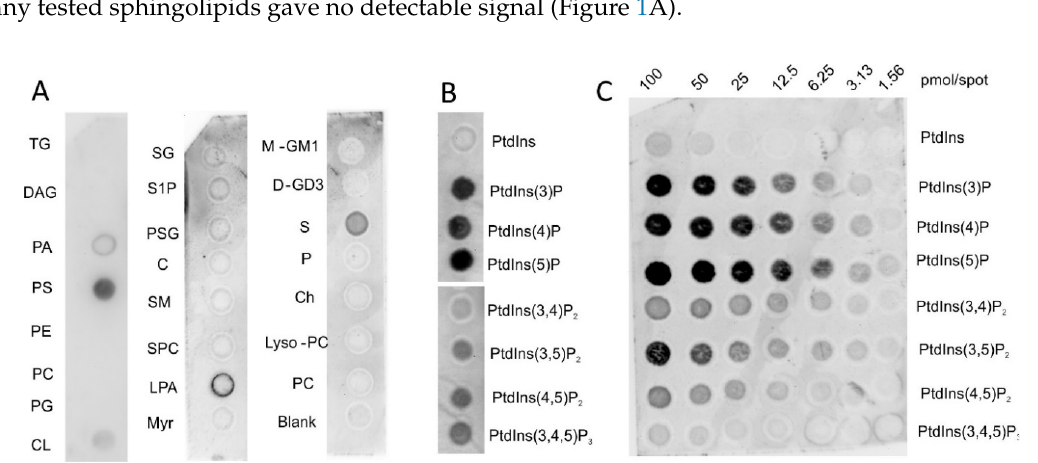
Figure 1. Vaspin affinity for immobilized membrane lipids. Shown are lipid overlay assays analyzing binding of vaspin to a variety of membrane lipids with 100 pmol/spot of lipid immobilized on each binding of vaspin to a variety of membrane lipids with 100 pmol / spot of lipid immobilized on spot and 1 μ g/mL vaspin was used for incubation of A ) membrane lipid and sphingo lipid strips, B ) each spot and 1 µ g / mL vaspin was used for incubation of ( A ) membrane lipid and sphingo PtdIns lipid strip and C ) PtdIns array with serial dilutions of different PtdInsPs from 100 pmol down lipid strips, ( B ) PtdIns lipid strip and ( C ) PtdIns array with serial dilutions of di ff erent PtdInsPs to 1.56 pmol/spot as indicated. TG: triglyceride, DAG: diacylglycerol, PA: phosphatidic acid, PS: from 100 pmol down to 1.56 pmol / spot as indicated. TG: triglyceride, DAG: diacylglycerol,